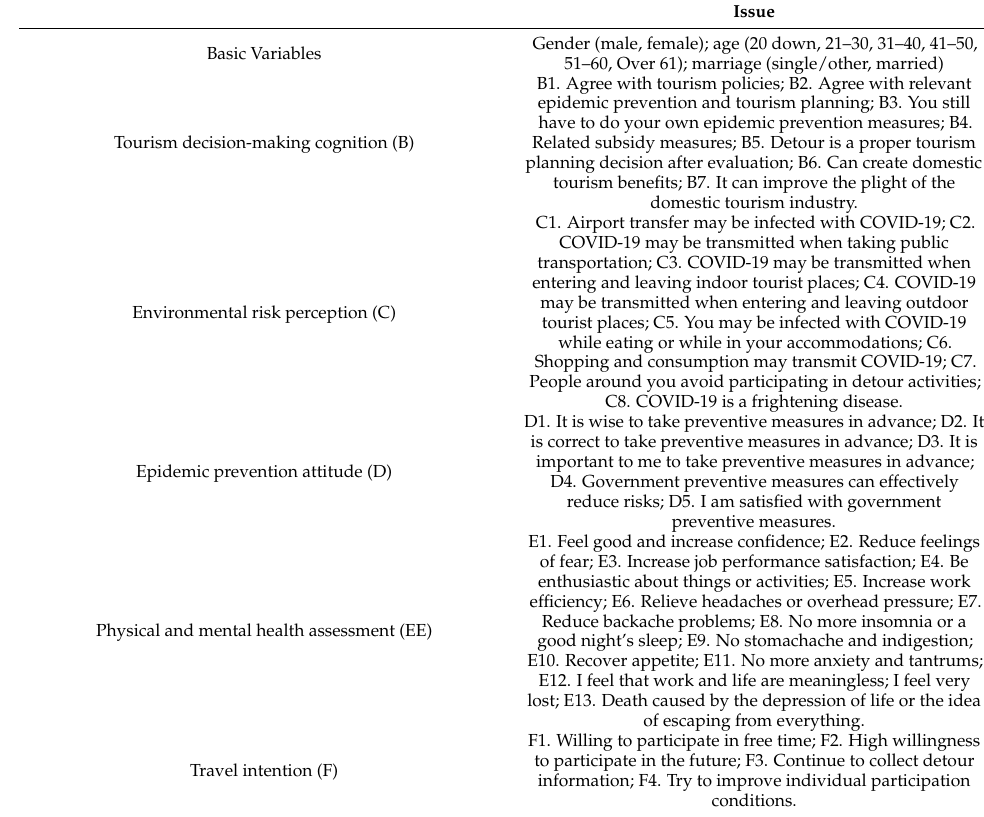
Table 1. Tourism decision-making cognition, environmental risk perception, epidemic prevention attitude, and physical and mental health assessment on travel